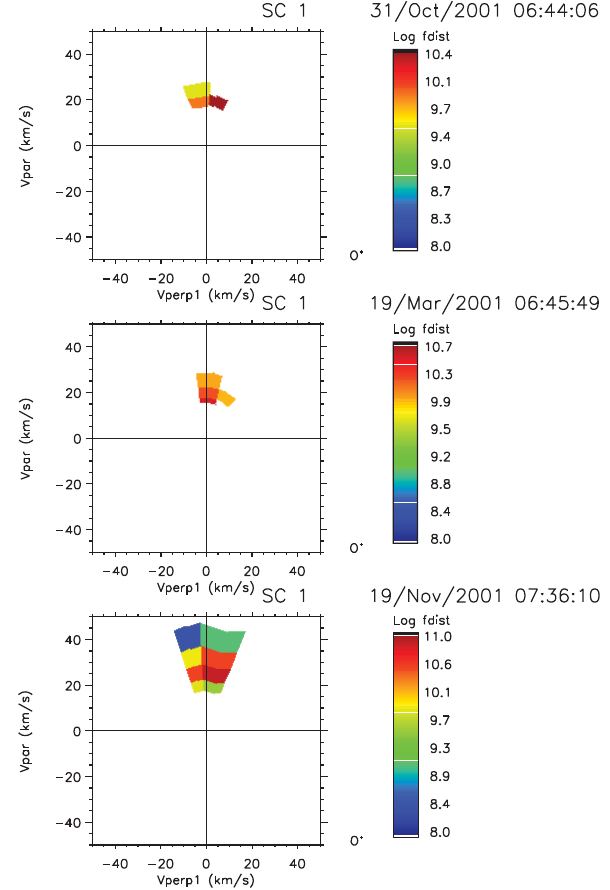
Figure 5. An example of velocity space distributions of O + ions measured on 31 October 2001, 19 March 2001 and 19 Novem- ber 2001. These distributions are shown according to the space- craft’s coordinate system and the velocity space is defined in terms of velocities parallel ( V par ) and perpendicular ( V perp ) to the mag- netic field direction. The scales are ± 50kms − 1 . The beams were also observed by SC3 and